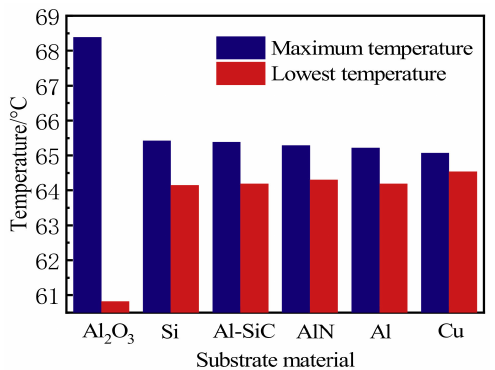
Figure 2. The maximum and minimum temperature of different substrate